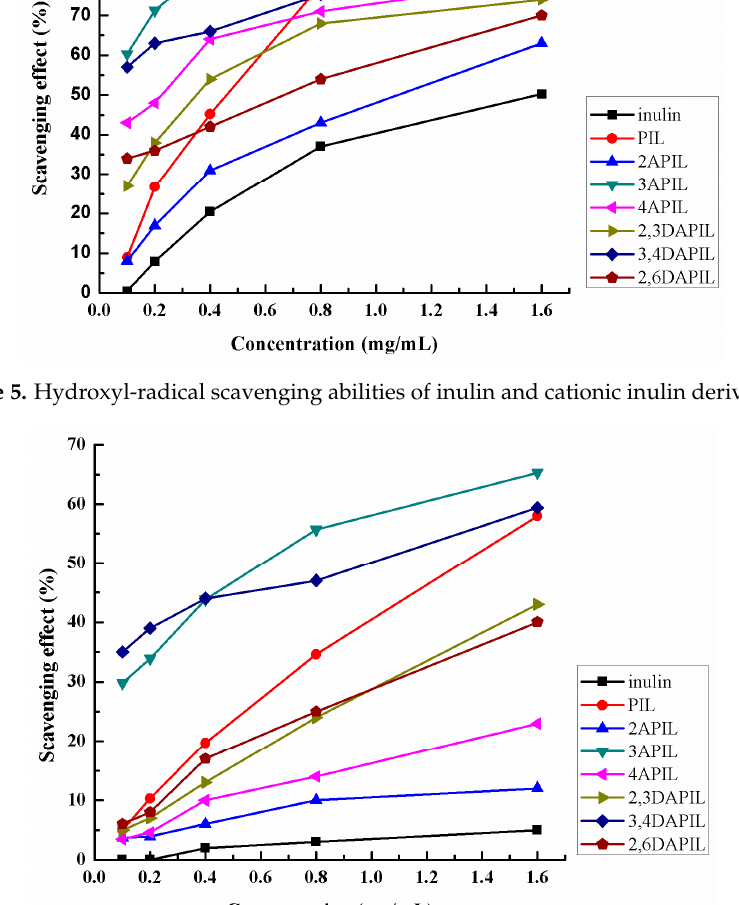
Figure 6. Diphenylpicryl phenylhydrazine (DPPH)-radical scavenging abilities of inulin and cationic inulin derivatives.